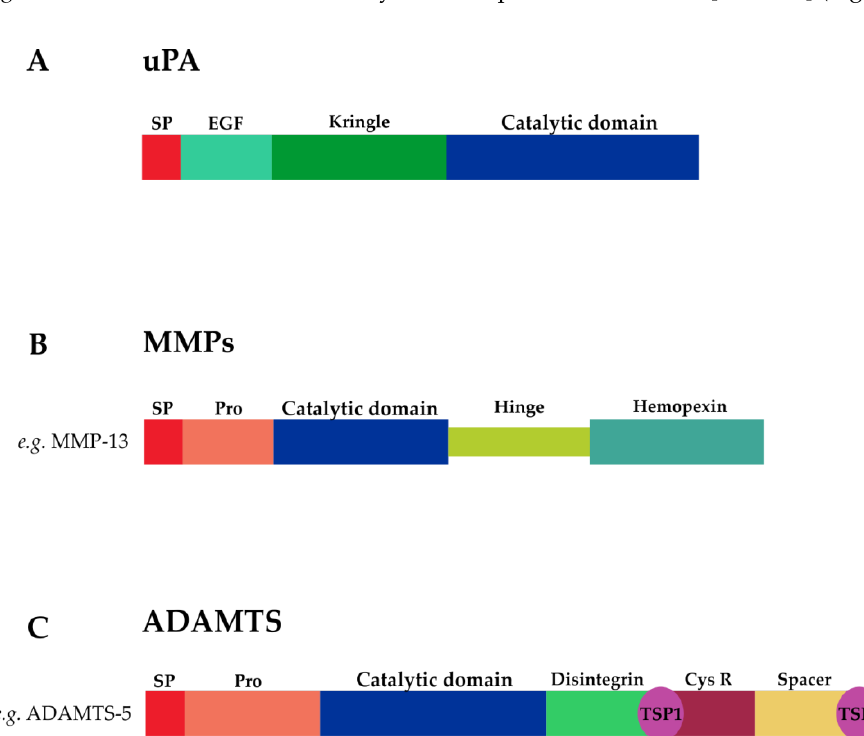
Figure 2. Schematic representation of proteinases involved in OA. ( A ) the serine proteinase uPA contains an N-terminal signal peptide (SP) followed by an epidermal growth factor (EGF)-like domain, a Kringle domain, and a catalytic domain. ( B , C ) the matrix metalloproteinase (MMP) and A disintegrin and metalloproteinase with thrombospondin motifs (ADAMTS) families have an N-terminal signal peptide, a pro-domain and a zinc-dependent catalytic domain. ( B ) In MMPs, the catalytic domain is followed by an hemopexin like-domain, ( C ) whereas, in the ADAMTS family, it is followed by a disintegrin domain and an auxiliary domain composed of a variable number of Thrombospondin type 1 (TSP-1), a cysteine-rich region (Cys R) and a spacer region, adapted from [54].